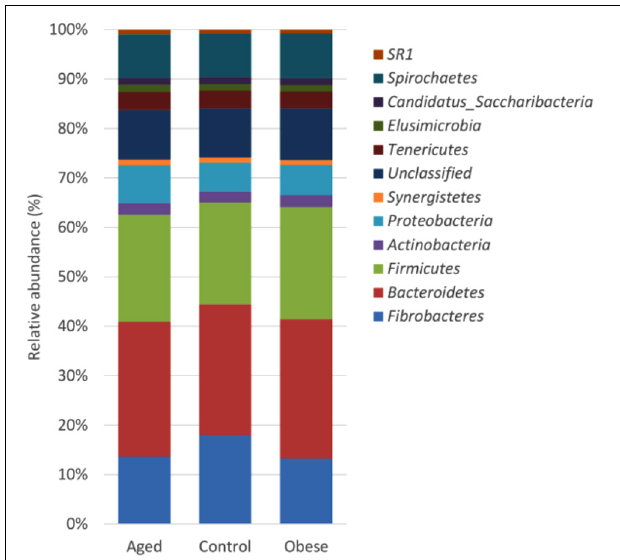
FIGURE 1 | Stacked histogram illustrating the relative abundance of the dominant bacterial phyla (present at > 0.05%) across host phenotypic groups [Aged ( n = 11), Control ( n = 12), and Obese ( n =